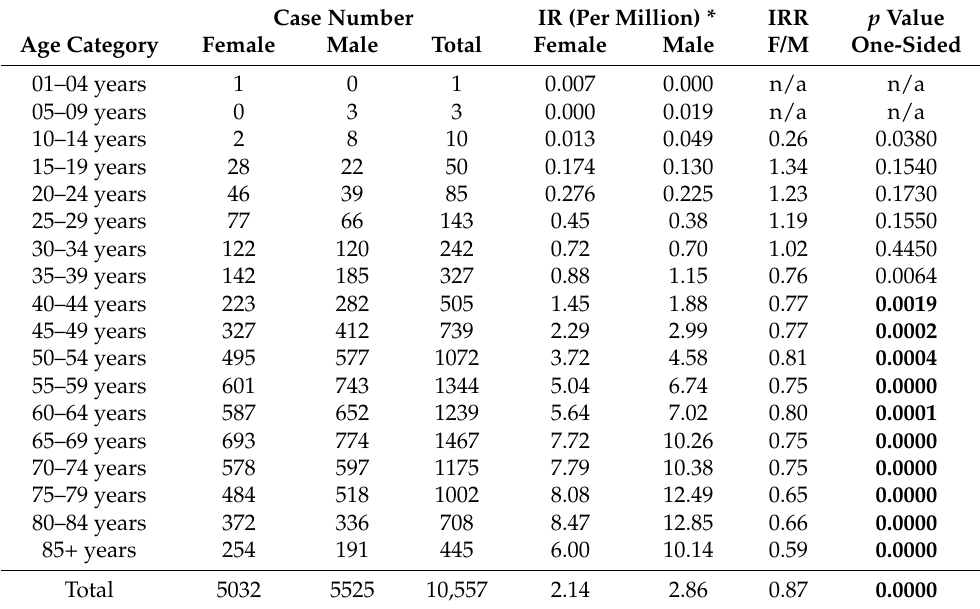
Table 1. Age-specific incidence rate difference in uveal